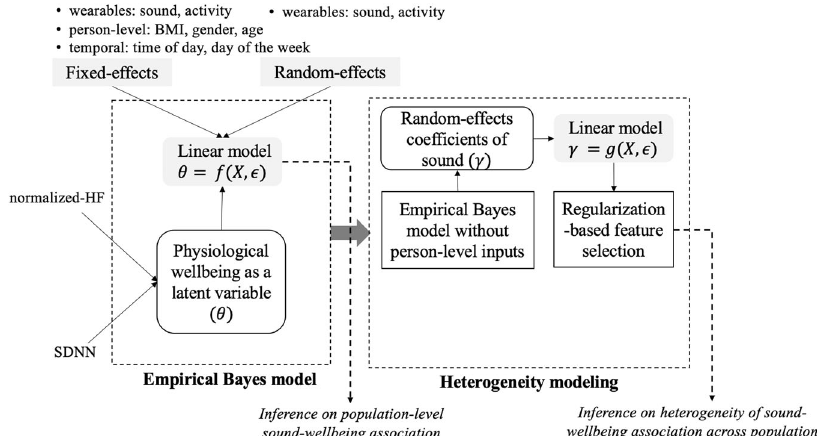
Fig. 4 Explanatory modeling framework consisting of an empirical Bayes model and heterogeneity modeling method for identifying population-level and interpersonal sound-wellbeing